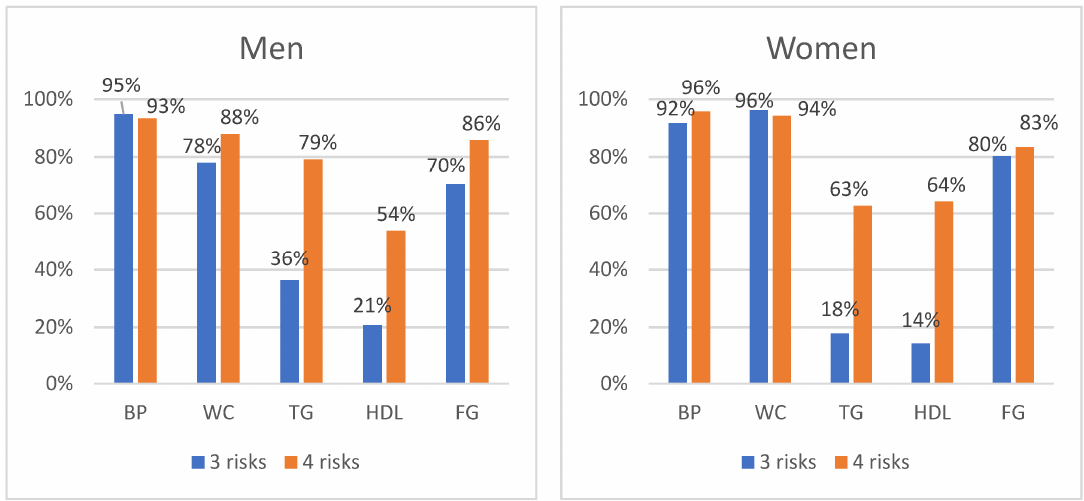
Figure 2. Proportions of metabolic syndrome risk number gathered in each quartile (%) for men and women.